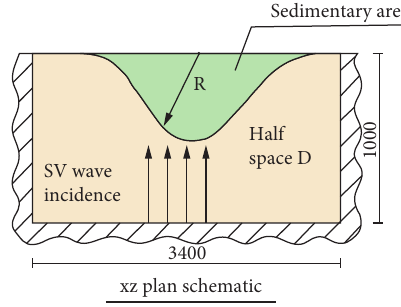
Figure 6: The YZ plane of two meandering river valleys.